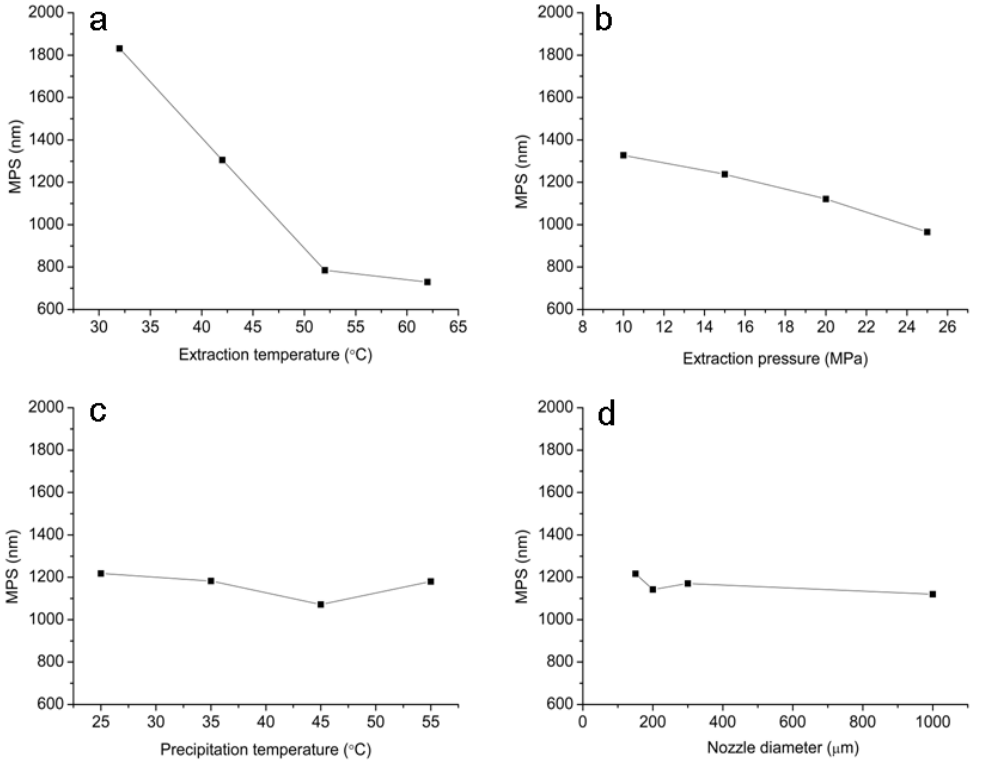
Figure 2. The effect of each parameter on the MPS of micronized artemisinin. ( a ) Extraction temperature; ( b ) Extraction pressure; ( c ) Precipitation temperature and ( d ) Nozzle